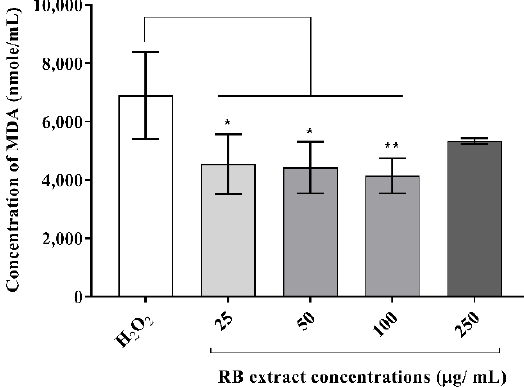
Figure 2. The impact of the RB phenolic extract treatment on oxidative stress-induced RAW264.7 macrophage cells. A significant reduction in the MDA concentration (nmol/mL) is observed after treatment with the different concentrations (25 – 100 µg/mL) of RB phenolic extracts compared to the control ( n = 5). The level of significance is indicated by the asterisks, whereby * p < 0.05, ** p < 0.01. Data are presented as mean ± SD. Mouse macrophage cell, RAW264.7; hydrogen peroxide, H 2 O 2 ; rice bran, RB.